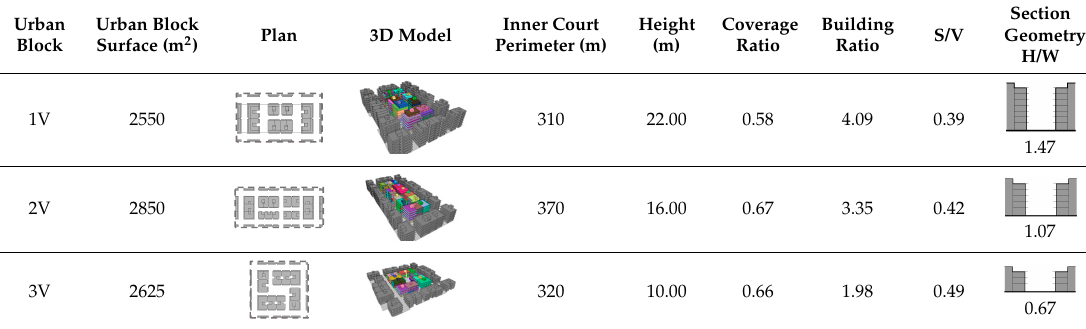
Table 20. Form and geometry parameters of typical urban blocks used for the validation of the regression models.